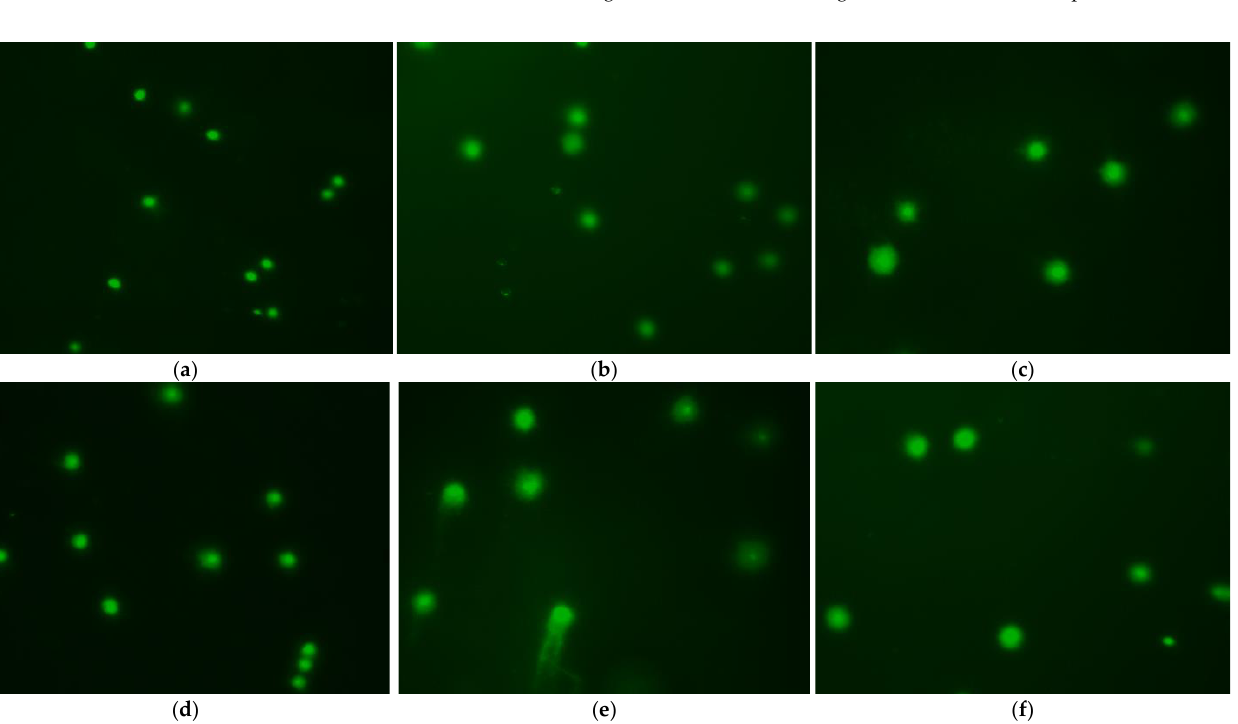
Different lowercase letters indicate significant differences among diluents. Control: fresh sperm.